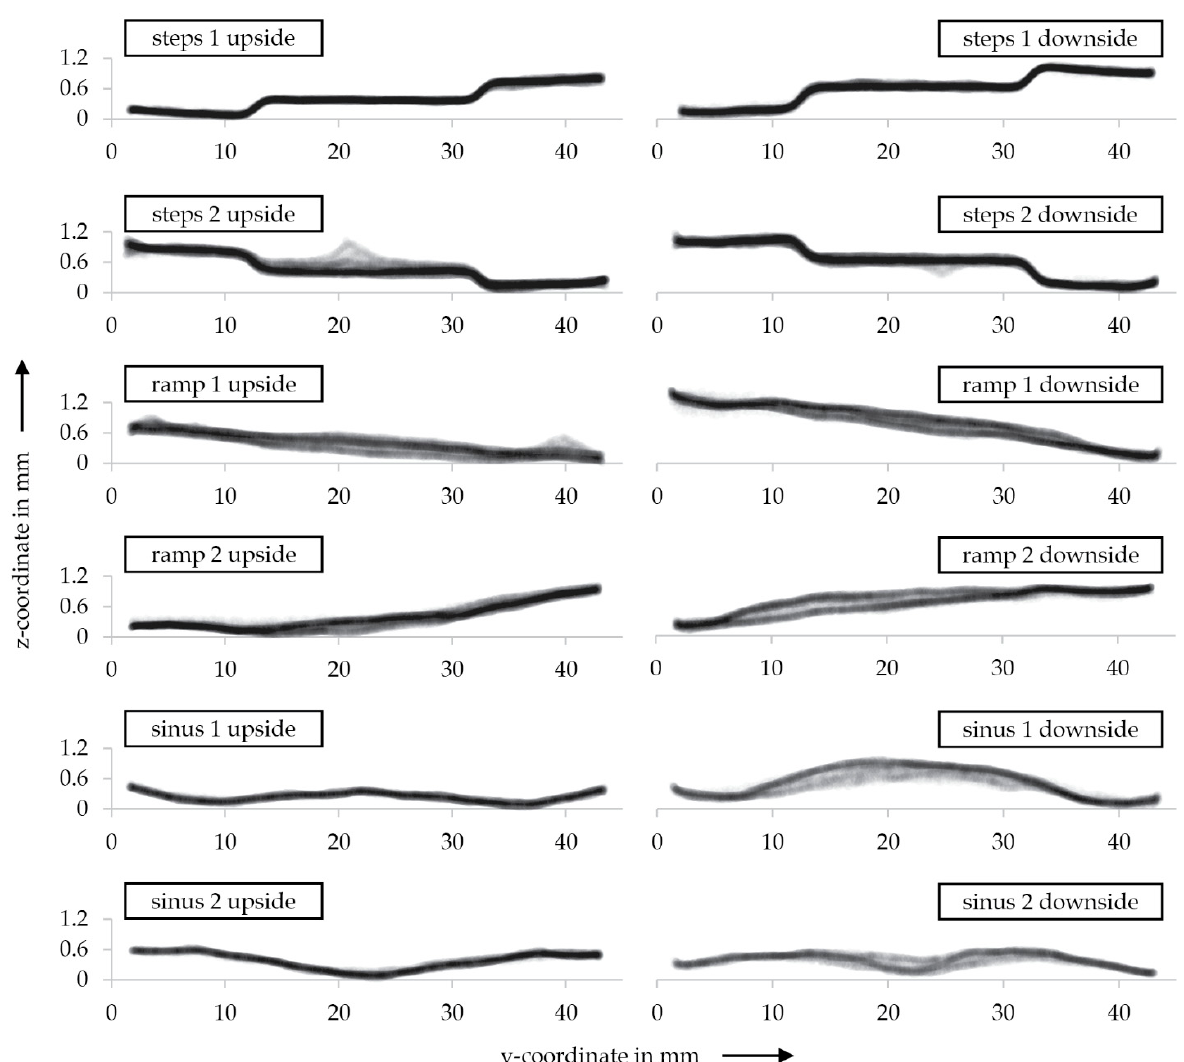
Figure 15. Pro fi le comparison of both upside ( left ) and downside ( right ) for steps 1 , steps 2, ramp 1 , Figure 15. Profile comparison of both upside ( left ) and downside ( right ) for steps 1, steps 2, ramp 1, ramp 2, sinus 1 and sinus 2. ramp 2, sinus 1 and sinus